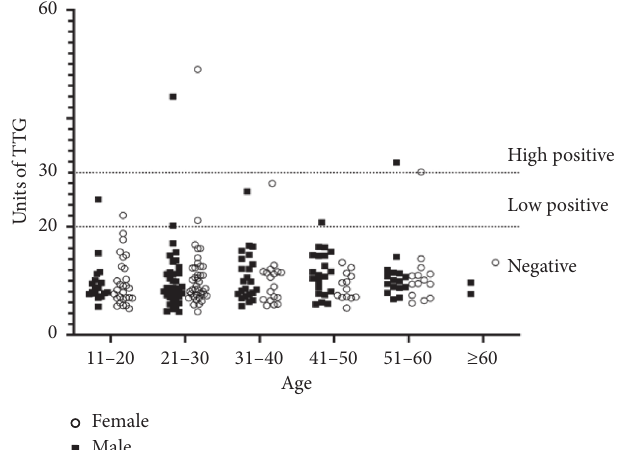
Figure 1: Distribution of seroreactive individuals according to age and sex. X -axis: donors were divided according to age distribution and sex. Y -axis: units of IgA anti-TTG according to reactivity: units ≥ 30 were considered high positives, 20–29 low positives, and < 20